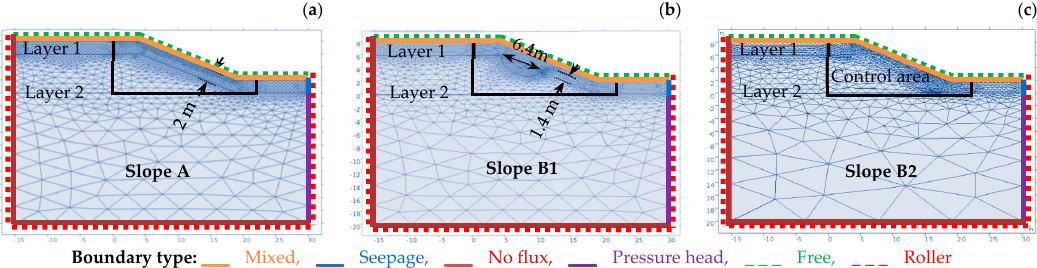
Figure 5. The geometry, boundary conditions, and FEM mesh of 2D slopes with two layers of ( a ) constant layer thickness (Slope A) following Shao et al. (2015) and ( b , c ) variable layer thickness (Slopes B1 and B2).